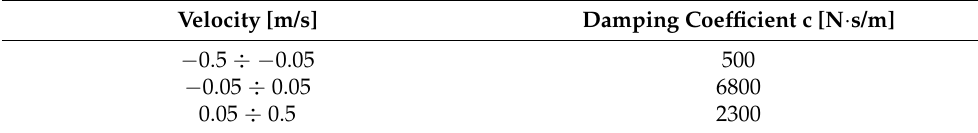
Table 1. Damping coefficient of the new shock absorber.